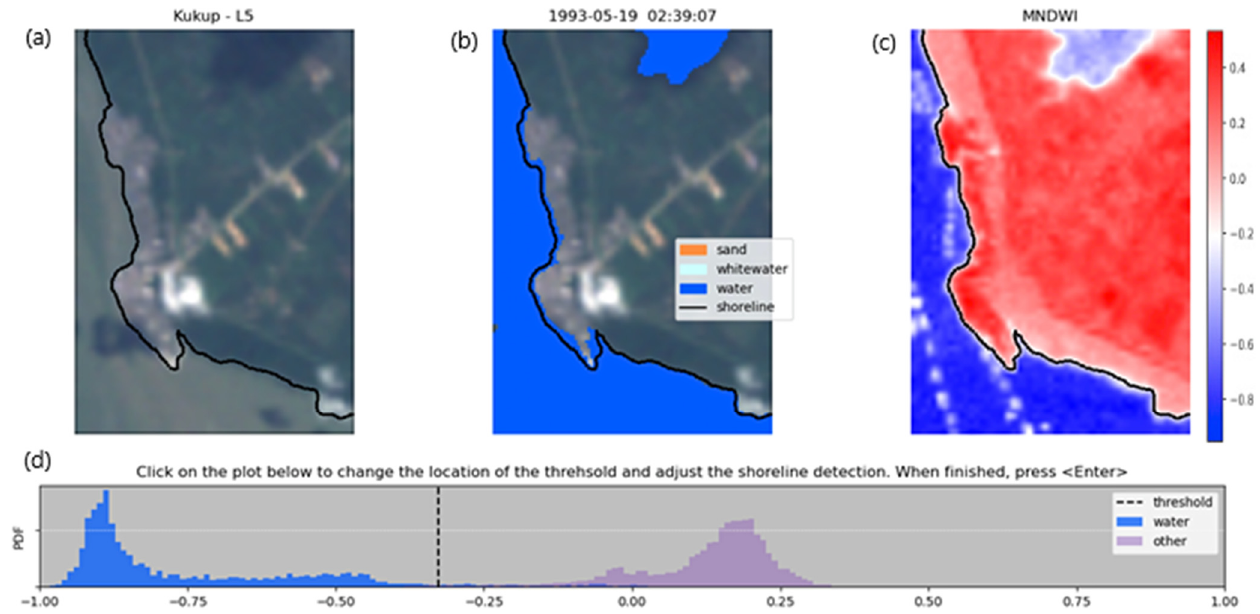
Figure 3. A sample processed Landsat 5 image of Kukup Beach: ( a ) an RGB composite; ( b ) output of the image classification with labels for the four classes; ( c ) single-colour-band image of the MNDWI pixel values; ( d ) refined thresholding peculiar to the sand and/water interface.